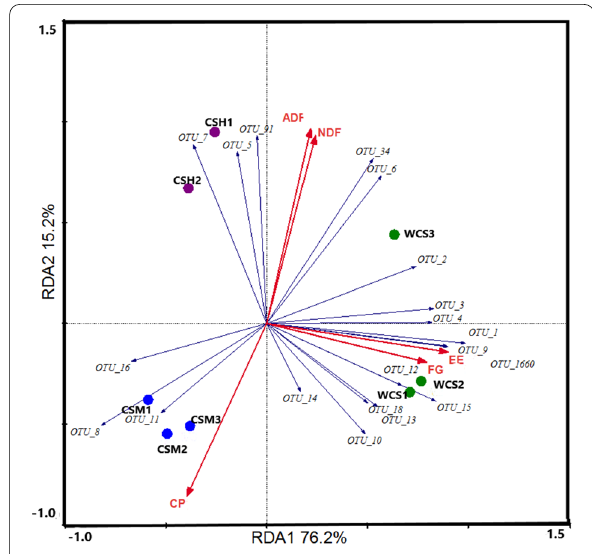
Fig. 2 Biplot of the redundancy analysis (RDA) based on the relative abundance of dominant genera (> 1% of total